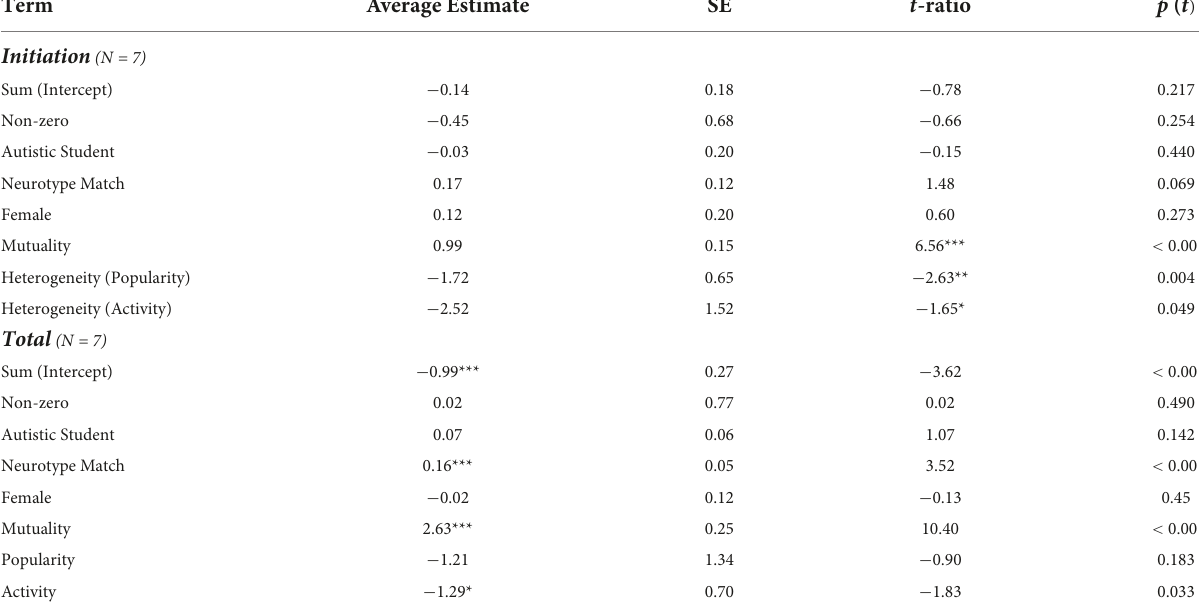
TABLE 5 Effects of neurotype match on peer connection in